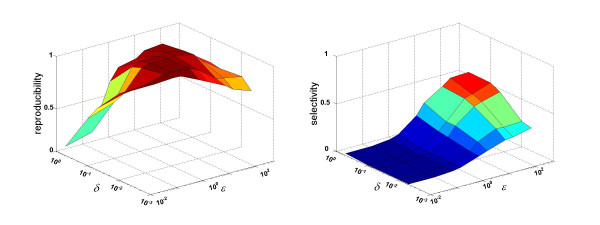
Reproducibility and selectivity. Reproducibility and selectivity of the described ant algorithm were characterized by defining two variables with 0 ≤ ε ≤ 100 and 0 ≤ δ ≤ 1. (A) Reproducibility defined as correlation between pheromone spectra in Eq. 8. (B) Selectivity defined as modified informational entropy in Eq. 9. The higher value represents a fewer peaks in the pheromone spectrum.